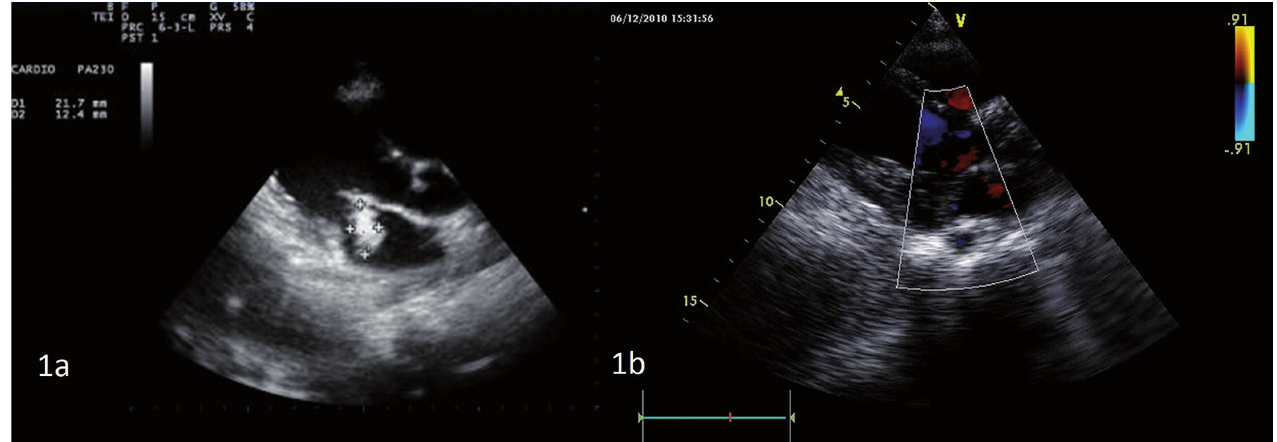
pericardiumFig. 1 – Transthoracic echocardiogram showing large mitral vegetation (31x 22